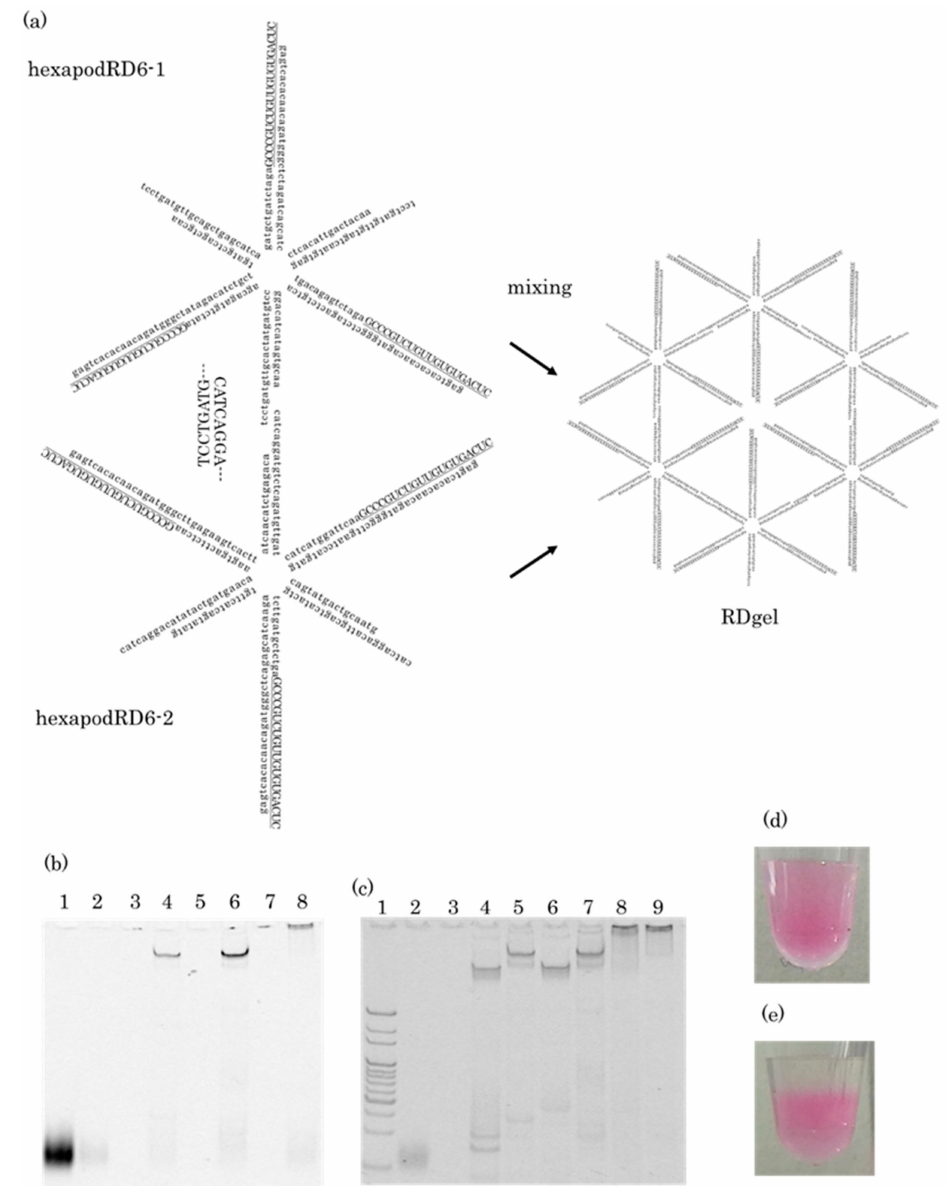
Figure 1. Preparation of hexapodRD6 and RDgel. ( a ) Putative structure of hexapodRD6 and the scheme for RDgel formation. The sequence of ORN-1 is underlined. Capital letters indicate phosphorothioate modification of inter-nucleotide linkages, and small letters indicate unmodified (phosphodiester) DNA. ( b ) Polyacrylamide gel electrophoresis (PAGE) analysis of FAM-ORN-1 and FAM-labeled nanostructured RNA / DNA based on FAM detection. Lane 1, FAM-ORN-1; lane 2, ORN-1; lane 3, hexapodD6-1; lane 4, FAM-hexapodRD6-1; lane 5, hexapodD6-2; lane 6, FAM-hexapodRD6-2; lane 7, hexapodD6-1 + hexapodD6-2; lane 8, FAM-hexapodRD6-1 + FAM-hexapodRD6-2. ( c ) PAGE analysis of ORN-1 and nanostructured RNA / DNA based on nucleic acid staining using SYBR GOLD. Lane 1, 20 base pair (bp) DNA ladder (TaKaRa Bio Inc., Otsu, Japan); lane 2, FAM-ORN-1; lane 3, ORN-1; lane 4, hexatetrapodD6-1; lane 5, FAM-hexapodRD6-1; lane 6, hexapodD6-2; lane 7, FAM-hexapodRD6-2; lane 8, hexapodD6-1 + hexapodD6-2; lane 9, FAM-hexapodRD6-1 + FAM-hexapodRD6-2. ( d ) Appearance of propidium iodide (PI)-stained hexapodRD6 after adding phosphate bu ff ered saline (PBS). ( e ) Appearance of PI-stained RDgel after adding